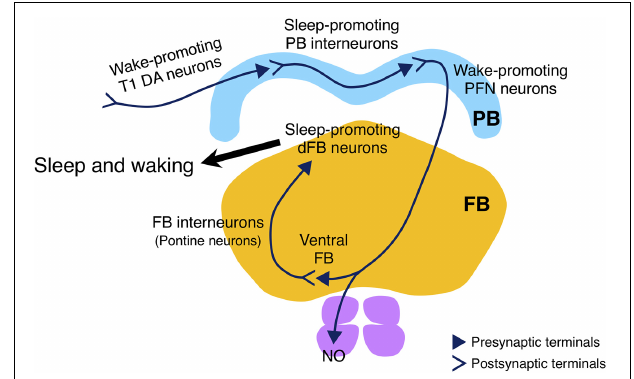
FIGURE 8 | Schematic drawing of the sleep-regulating neuronal circuit in the PB. The circuit consists of the sleep-promoting PB interneurons and the wake-promoting PFN neurons, and is regulated by wake-promoting T1 DA neurons. The wake-promoting PFN neurons indirectly inhibit the sleep-promoting dFB neurons via FB interneurons (Kato YS et al., unpublished